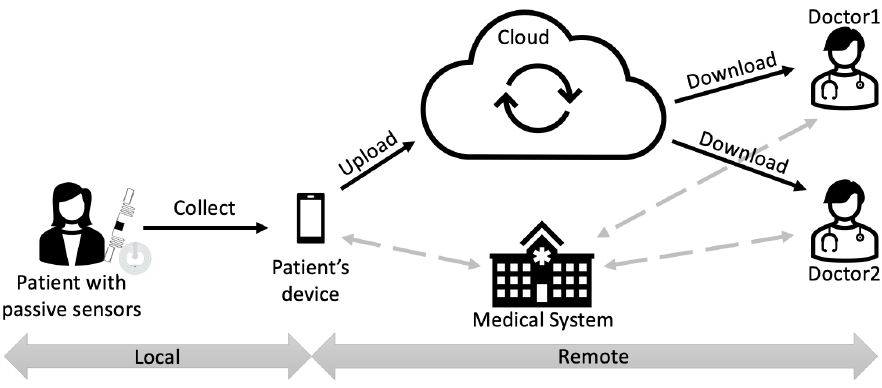
Figure 4. Considered scenario of NFC and RFID sensors for a healthcare